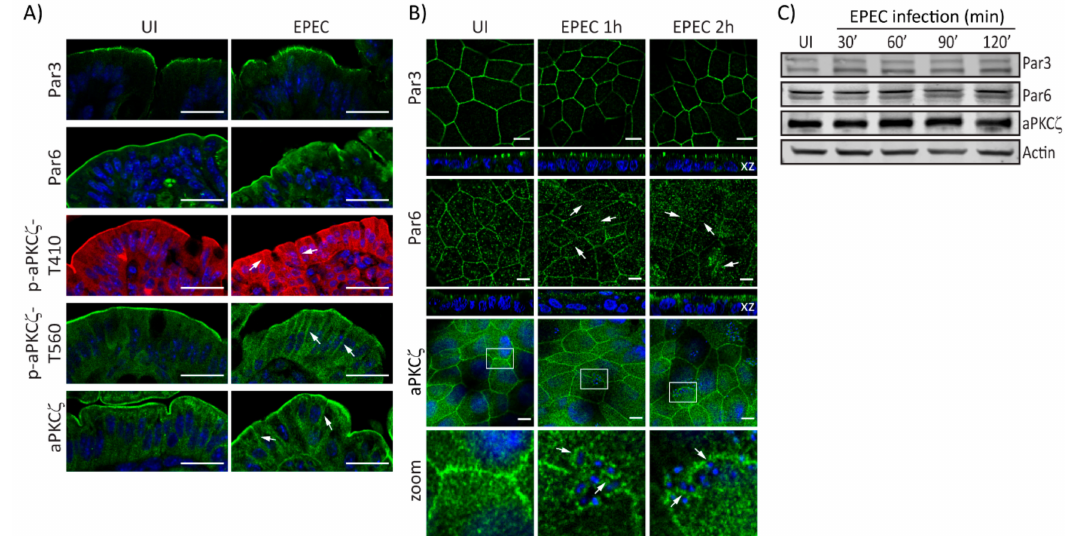
Figure 1. EPEC alters PAR complex localization. ( A ) Immunofluorescence microscopy of murine colonic epithelial tissue 3 days post-infection with EPEC or not (uninfected—UI). Par3 localization is unchanged. Par6 accumulates within the cytoplasm. Phosphorylated aPKC ζ –T410, aPKC ζ –T560, and total aPKC ζ mislocalize from the apical membrane and accumulate within the cytoplasm and lateral membrane (arrows). Scale bar: 40 µ m. ( B and C ) SKCO-15 monolayers were infected, or not (UI), with EPEC at indicated times, then the localization and protein levels of PAR complex proteins were assessed by immunofluorescence and western blot, respectively. ( B ) Par3 localization is unaltered by EPEC infection, and Par6 redistributes from cell–cell contacts to the cytoplasm (arrows). aPKC ζ localizes under attached bacteria (arrows, inset zoom). Hoechst was used to stain host and bacteria nuclei (blue). Scale bar: 10 µ m. ( C ) EPEC does not change the expression levels of PAR complex proteins; β -actin was used as a loading